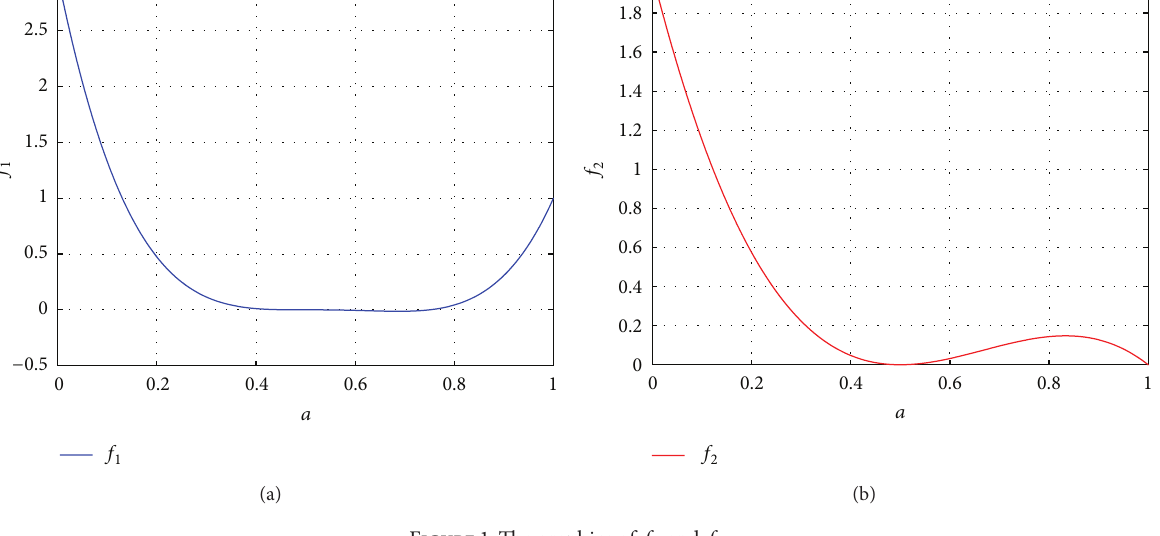
Figure 1: The graphics of 𝑓 1 and 𝑓 2